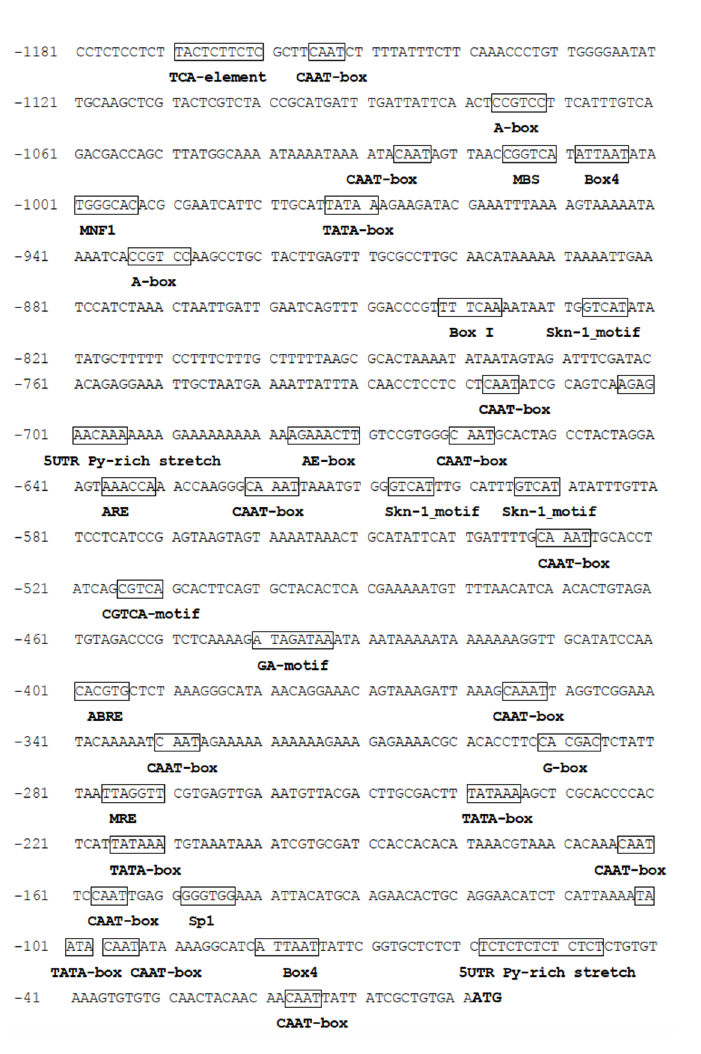
Figure 3. Core elements in the PtAOS1 promoter. The ATG in bold is the start codon of the PtAOS1 gene; the boxed region represents predicted cis-acting elements. 5UTR Py-rich stretch: cis-acting element conferring high transcription levels; A-box: cis-acting regulatory element associated with P- and L-box involved in induced transcriptional activity; ABRE: cis-acting element involved in the abscisic acid responsiveness; AE-box: part of a module for light response; ARE: cis-acting regulatory element essential for the anaerobic induction; Box4: part of a conserved DNA module involved in light responsiveness; Box I: light responsive element; CAAT-box: common cis-acting element in promoter and enhancer regions; CGTCA-motif: cis-acting regulatory element involved in MeJA responsiveness; G-box: cis-acting regulatory element involved in light responsiveness; GA-motif: part of a light responsive element; GT1-motif: light responsive element; MBS: MYB binding Site; MNF1: light responsive element; MRE: MYB binding site involved in light responsiveness; Skn-1_motif: cis- acting regulatory element required for endosperm expression; Sp1: light responsive element; TATA- box: core promoter element around − 30 of transcription start; TC-rich repeats: cis-acting element involved in defense and stress responsiveness; TCA-element: cis-acting element involved in salicylic acid responsiveness. Transient expression assays were used to examine a core region in the PtAOS1 promoter. Promoter P − 1181 ( − 1181 to +1) and its truncated fragments P − 1062 ( − 1062 to +1), P − 922 ( − 922 to +1), P − 668 ( − 668 to +1), P − 532 ( − 532 to +1) and P − 265 ( − 265 to +1) were assigned to drive a yellow fluorescent protein (YFP) in tobacco leaves. A YFP signal driven by P − 1182 was detected successfully in tobacco epidermal cells which illustrated the transcription activation of the PtAOS1 promoter. A YFP driven by P − 1062 , P − 922 , P − 668 and P − 532 fragments exposed a fluorescence signal equally with that using P − 1182 . However, a YFP signal with a P − 265 fragment drive decreased sharply, implying a core function lost (Figure 4A–C).